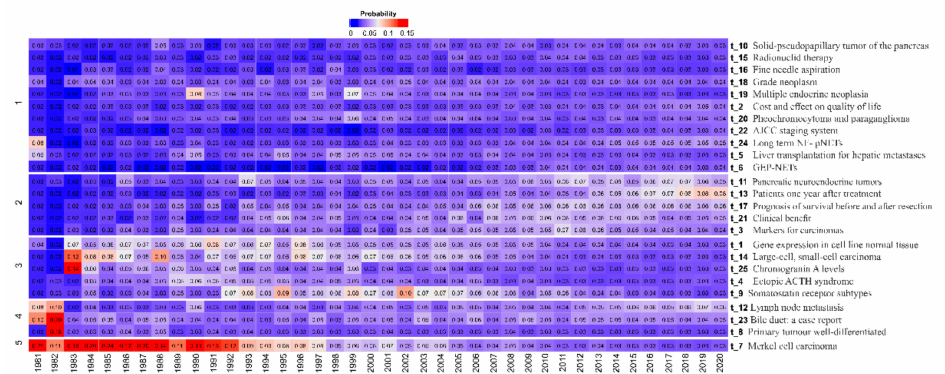
Figure 7. Representation of the distribution of topics by year through the heat